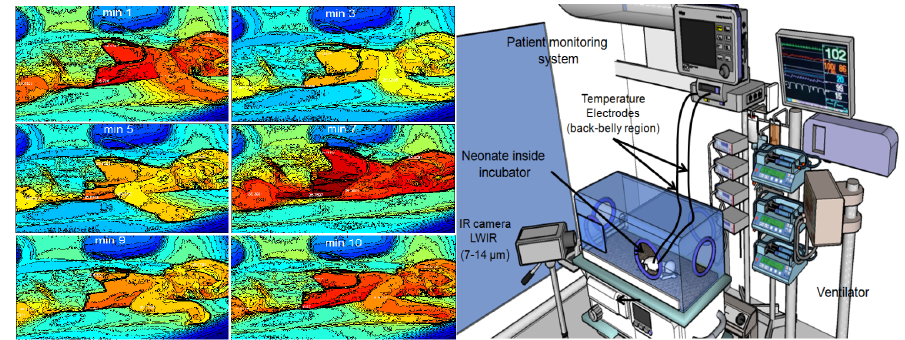
Figure 10. ( Left ) sequence of the neonatal thermograms showing the evolution of temperature distribution over time (photos reprinted from previous work of the author); ( Right ) typical experimental setup of neonatal infrared thermography (NIRT), including an Long wave infrared (LWIR) camera and associated vital sign monitoring inside an incubator